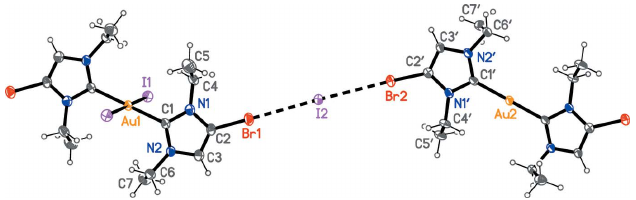
Figure 3 Structure of compound 4 ; the asymmetric unit has been extended by symmetry to show complete cations. Ellipsoids represent 50% probability levels. The dashed lines indicate halogen bonds.